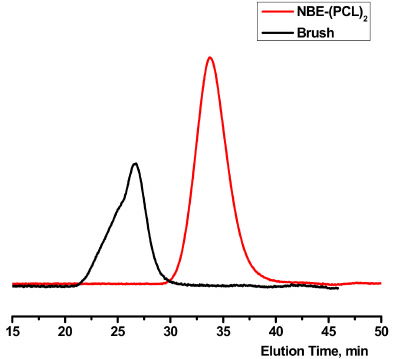
Figure 5. SEC traces monitoring the synthesis of DB-PLLA.